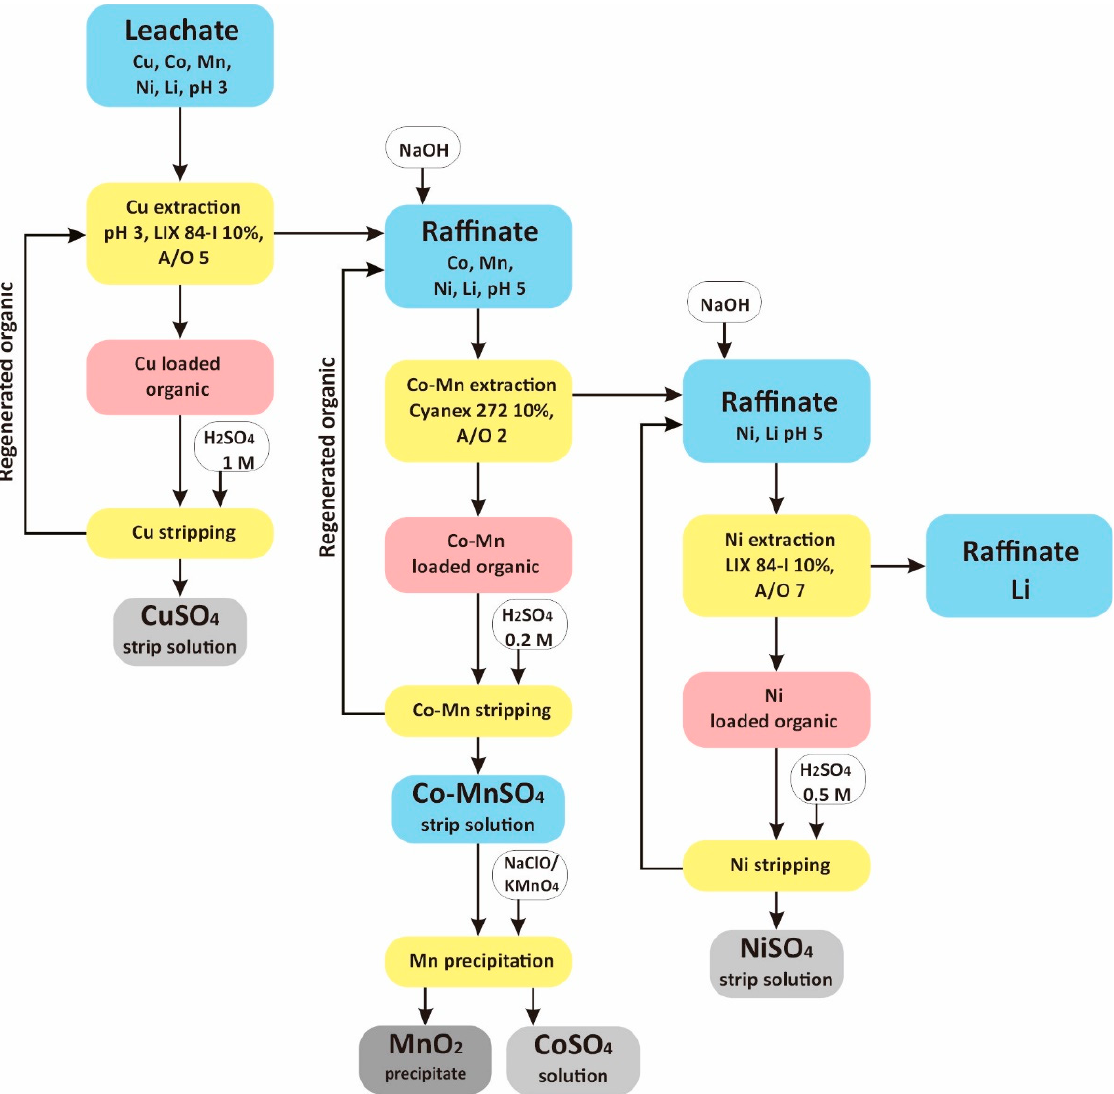
Figure 10. Proposed scheme for transition metal fractionation from LIB leach liquor (tannic acid-acetic acid media) by solvent extraction and oxidative precipitation.